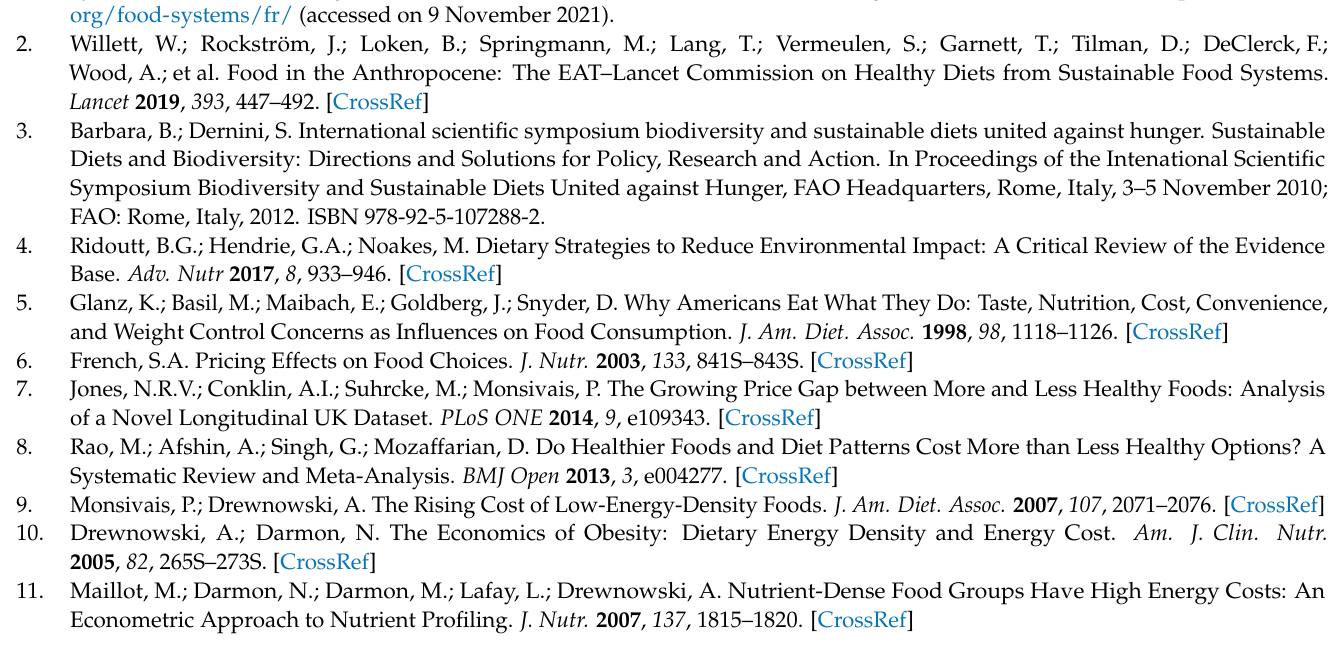
Table S2. Methods used to calculate a price for the Bureau of Nutritional Science (BNS) food groups; Table S3. Non-energy adjusted daily diet cost according to sociodemographic